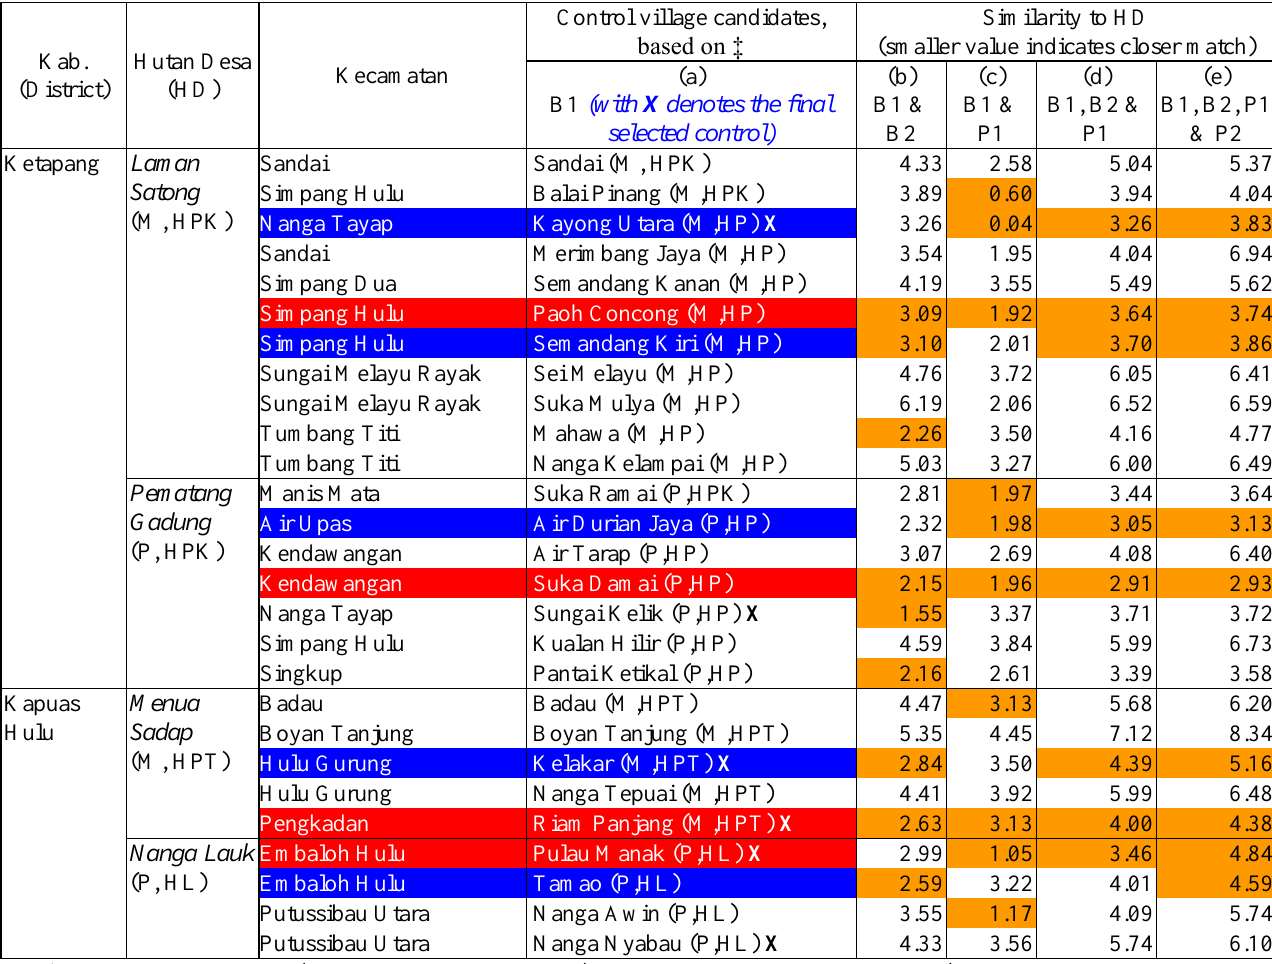
Table A1.1. List of control villages for each HD based on variables used in matching: (a) B1 (primary biophysical variables), (b) B1 & B2 (both primary and secondary biophysical variables), (c) B1 & P1 (primary biophysical and basic human wellbeing variables), (d) B1, B2 & P1 (biophysical and basic human wellbeing variables), and (e) B1, B2, P1 & P2 (biophysical, basic human wellbeing and infrastructure variables) (see Table 2 for baseline variables B1, B2, P1 & P2). Cell highlighted in orange represents the eligible control based on matching variables for column (b)- (e). Cell highlighted in red represents the most suitable control village (closest match to HD), and cell highlighted in blue represents the second most suitable control village. The final control was selected minimizing column (b) or (c).